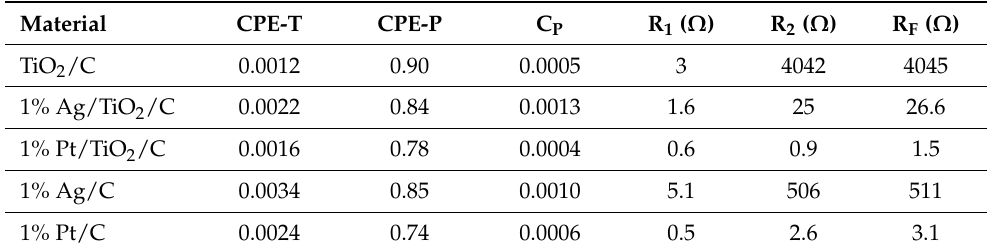
Table 3. Electric equivalent circuit parameters of catalysts where CPE–T is related to capacitance and CPE–P to irregularity of the analyzed surface tending to 1 for perfectly flat surfaces. The faradaic resistance R F corresponds to the sum of resistors R 1 and R 2